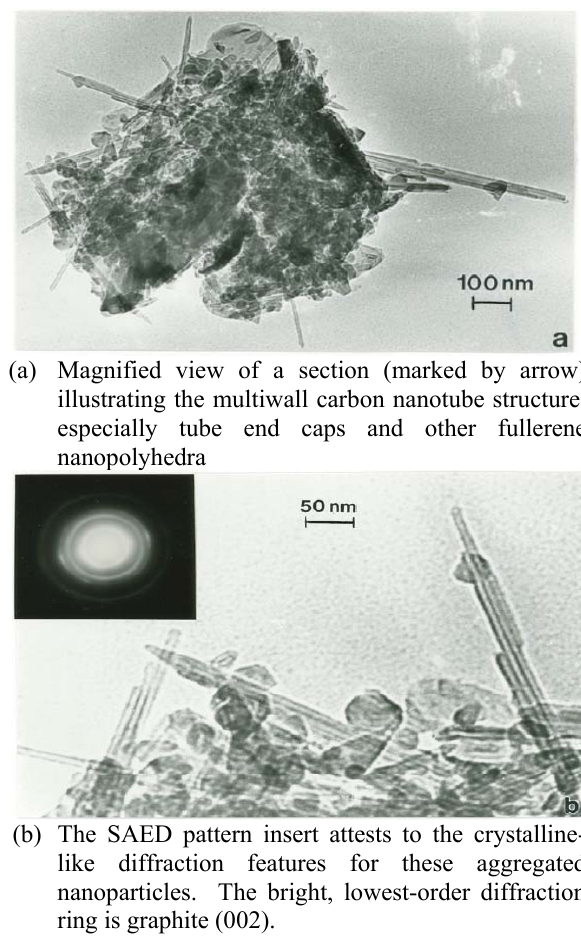
Figure 1: TEM bright-field images of SWCNT-1 and MWCNT-N carbon nanotube aggregates.